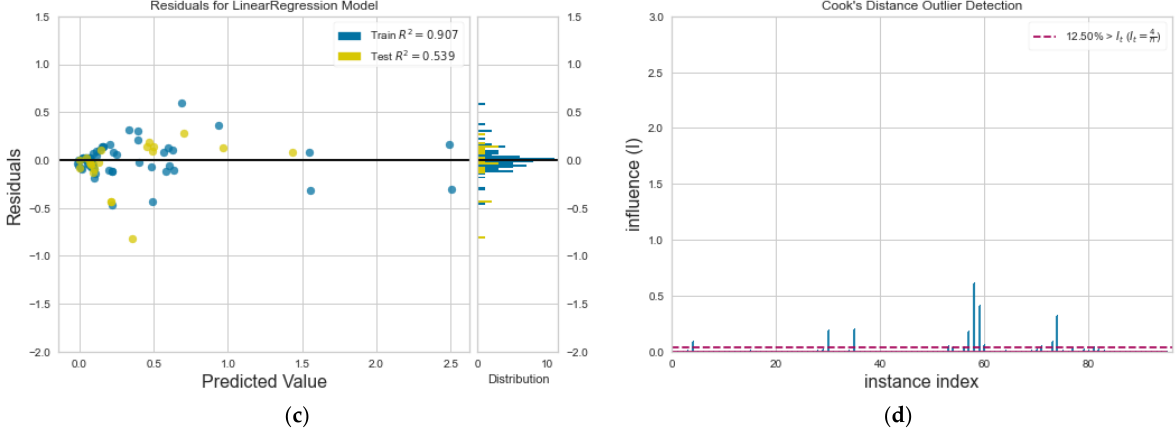
Figure 9. ( a ) Residuals plot and ( b ) Cook’s distance for u m , and, after the removal of outliers from the dataset, ( c ) new residuals plot and ( b ) new Cook’s distance.